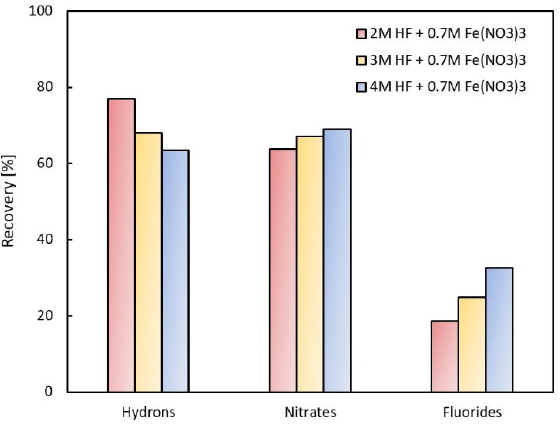
Figure 4. Comparison of recovery for different acid concentrations (150 mL h − 1 ).